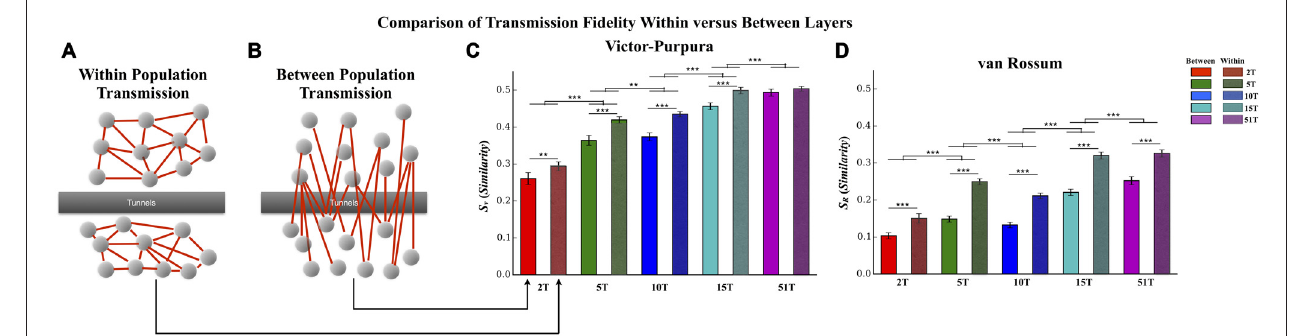
FIGURE 6 | Comparison of transmission fidelity within vs. between layers . Unlike transmission between layers where activity among one population of neurons must cross the tunnels to reach the second layer (illustrated in B ), transmission within each layer (illustrated in A ) would be unimpeded tunnels, should represent intrinsic wiring of the network, and might therefore produce the highest possible fidelity estimates during transmission. In fact in the majority of cases transmission fidelity was higher during measurements of within layer communication compared to communication between layers based fidelity estimates using the Victor-Purpura (C) and von Rossum metrics (D) . However, we also found that increasing the number of tunnels led to an overall increase in fidelity even among the communication within each layer. This latter effect is surprising in that within layer connectivity should have been the same across the groups (Error bars represent